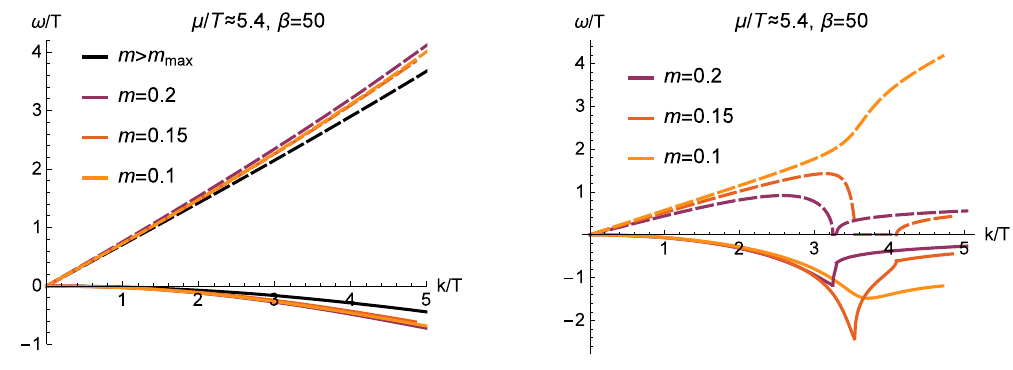
Figure 15 . The linear QNM (left) and ‘cloud’ CM (right) at (cid:22)=T (cid:25) 5 : 4 and (cid:12) =